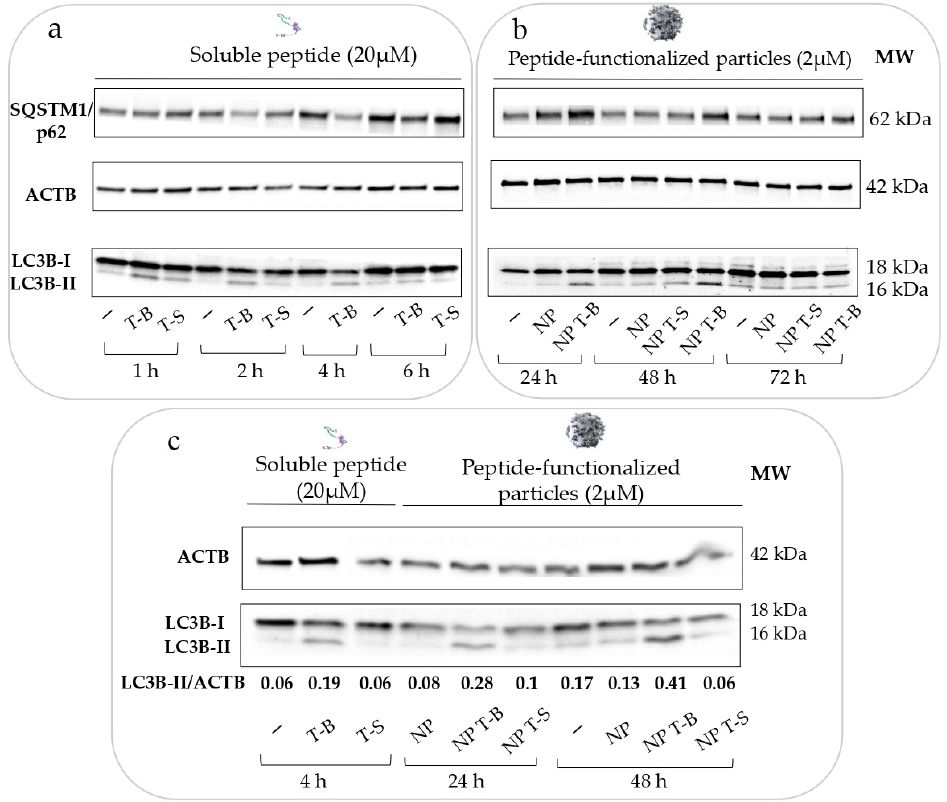
Figure 2. Particles formulated with the Tat-Beclin peptide modulate autophagy (taking LC3-II as a marker for autophagy) in a sustained and delayed manner, and at a ten times lower concentration compared to the soluble peptide in HeLa cells. ( a ) Autophagy modulation by the soluble Tat-Beclin peptide in HeLa cells over 6 h. HeLa cells were treated with 20 µM of soluble peptide for the respective time points before cell lysis, protein extraction and Western blot analysis of p62 and LC3B as autophagy markers. ( b ) Autophagy modulation by the functionalized particles (NP T-B or NP T-S at 2 µM) or plain particles (NP) at 24, 48 and 72 h post treatment. ( c ) Autophagy modulation by the soluble T-B or NP T-B at their peak of autophagic activity (4 h for the soluble peptide, 24 and 48 h for the NP T-B) and quantification of autophagy modulation (LC3B-II/ACTB ratio). All blots are representative of at least three independent experiments.